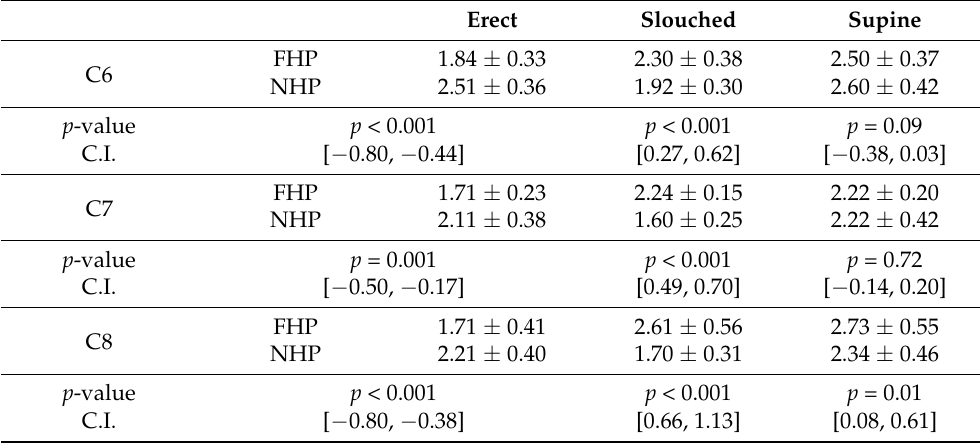
Table 2. Two-way analysis of variance results. FHP = forward head posture group, NHP = neu- tral head posture group, Erect = neutral upright sitting posture, Slouched = slouched or slumped sitting posture, Supine = lying supine analysis, C6, C7, C8 = the respective nerve roots tested, C.I. = confidence interval.